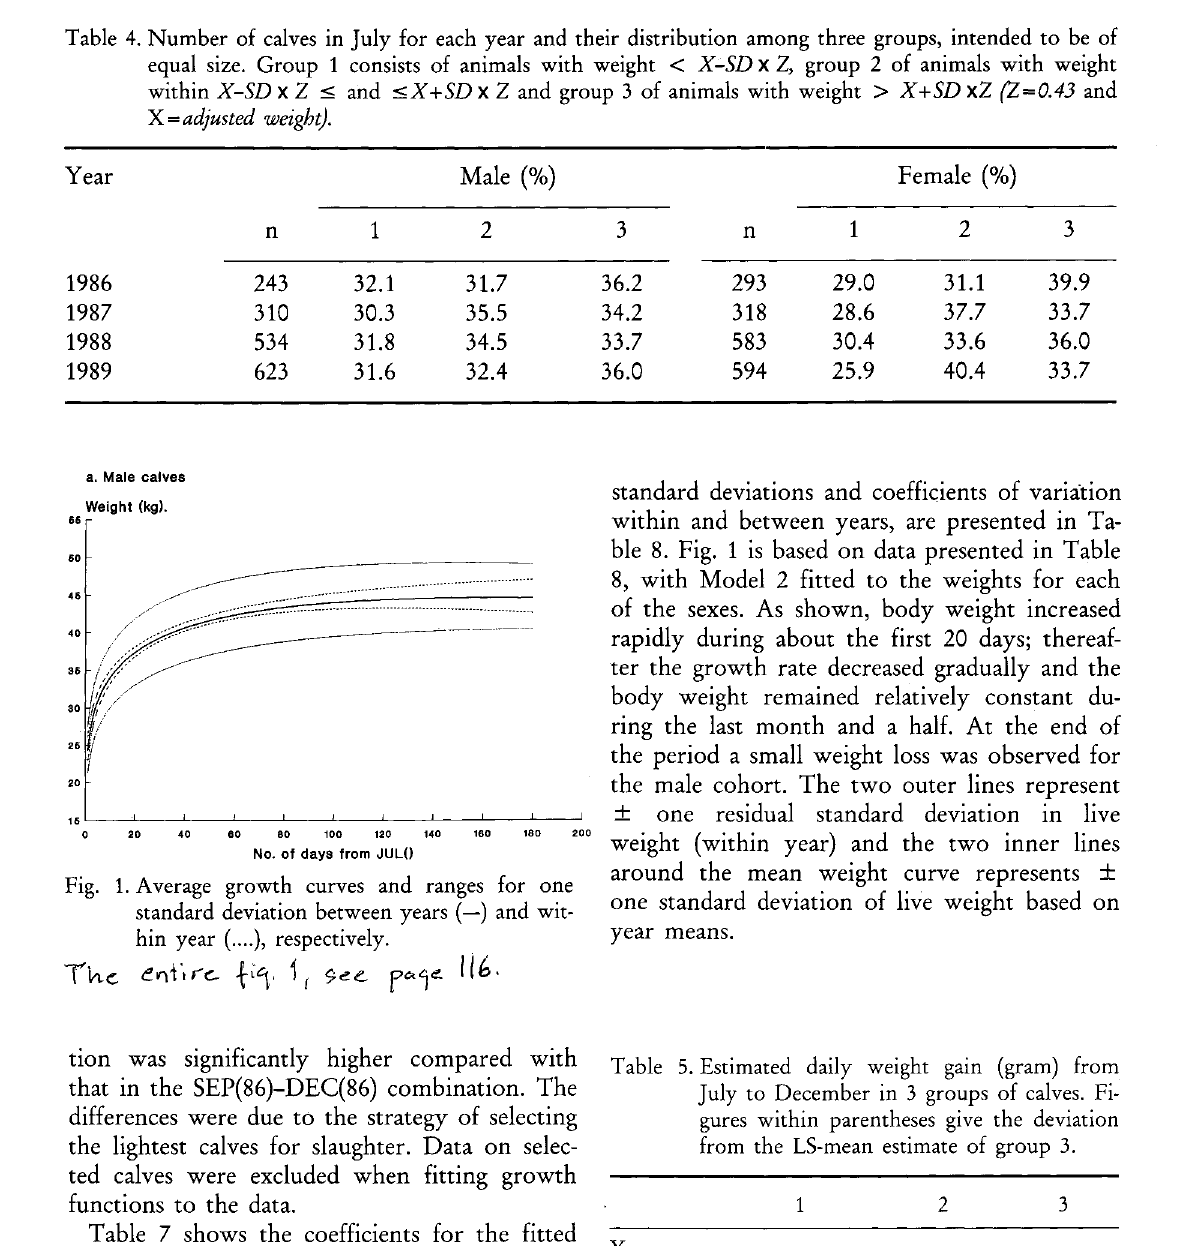
Table 5. Estimated daily weight gain (gram) from July to December in 3 groups of calves. Fi gures within parentheses give the deviation from the LS-mean estimate of group